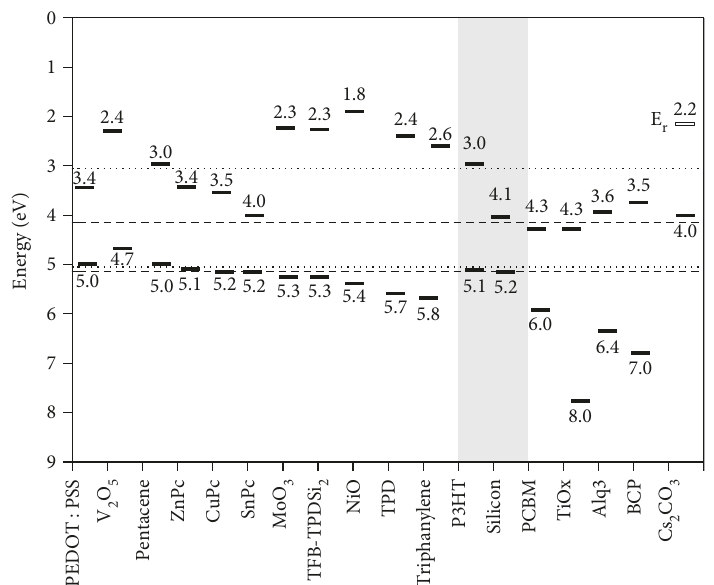
Figure 4: Bandgap energies (LUMO-HOMO levels) for several HT/EB layer materials to the left of the absorbers (P3HT, silicon in gray stripe) and ET/HB layer materials to the right